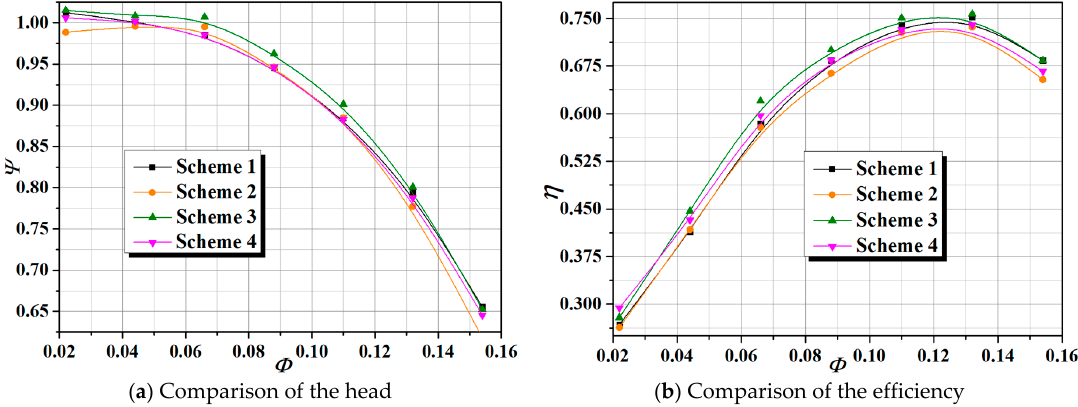
Figure 16. Head and efficiency under various flow conditions.